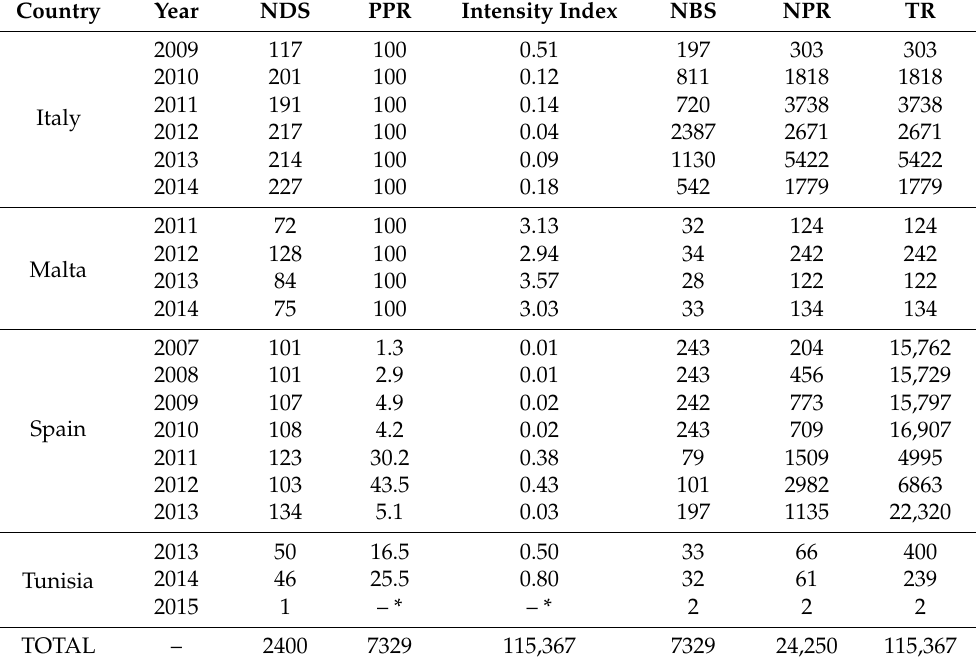
Table 1. Citizen science data summary for all the countries. NDS: number of days surveyed, PPR: percentage of positive (presence) reports, NBS: number of beaches surveyed, NPR: number of positive (presence) reports, TR: total reports (presence + absence). TOTAL represents the sum of variables, except for PPR and intensity index, which represents the average (and standard error) values (* –: due the small sampling effort of this year, this data were not considered in the analysis). Country Year NDS PPR Intensity